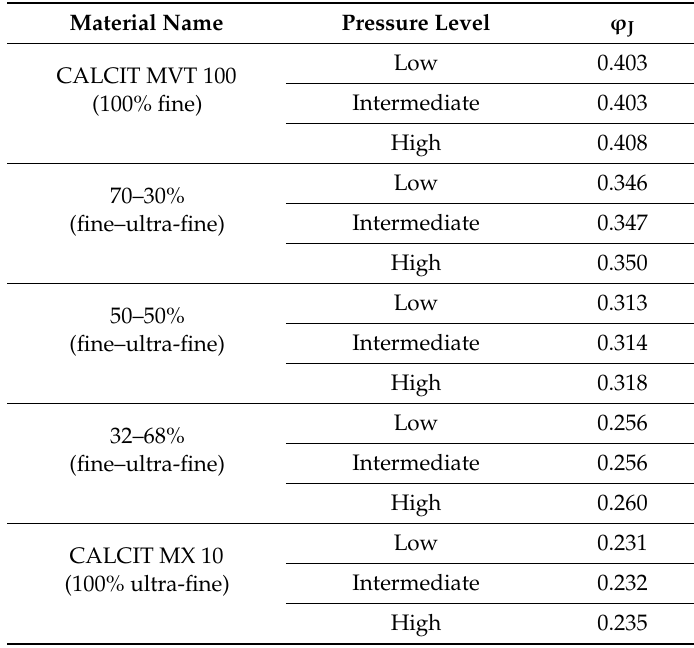
Table 5. Jammed particle volume fraction of di ff erent mixtures for di ff erent pressure